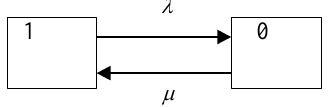
Figure 3. Two-state model for a converter station.